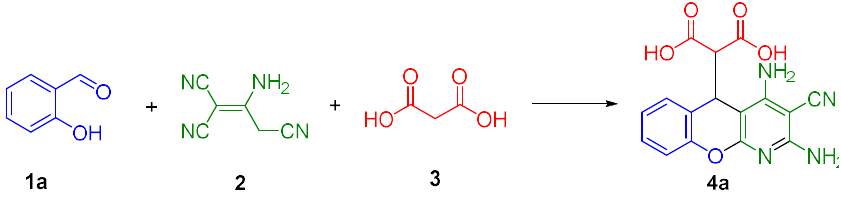
Table 1. Multicomponent synthesis of 2-(2,4-diamino-3-cyano-5 H -chromeno[2,3- b ]pyridine-5- yl)malonic acid 4a 1